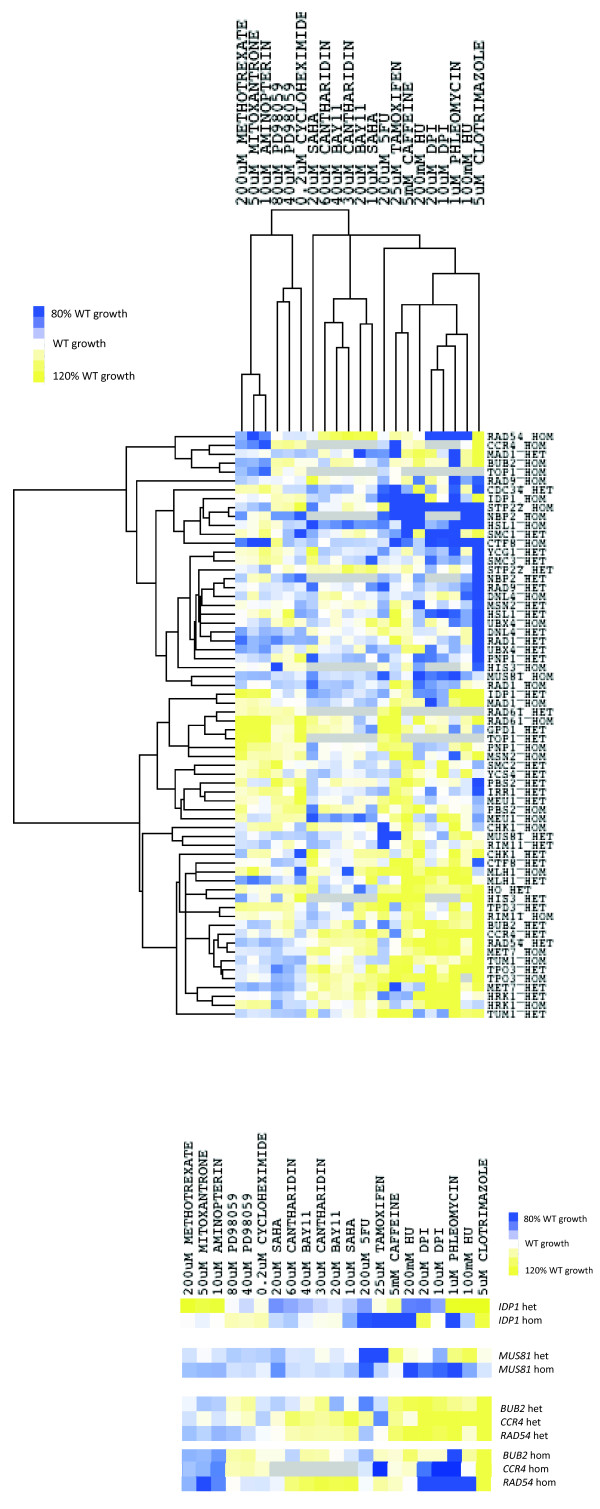
Interrelationships of drug-response profiles of yeast deletion mutants. Left panel: Hierarchical clustering of the response of the heterozygous and homozygous deletion mutants of the HPGI set to treatment with a panel of anti-cancer compounds. Right panel: Comparison of the drug-response profiles for the heterozygous and homozygous mutants of those HPGI genes for which cancer drug sensitivity differs markedly according to gene copy number.